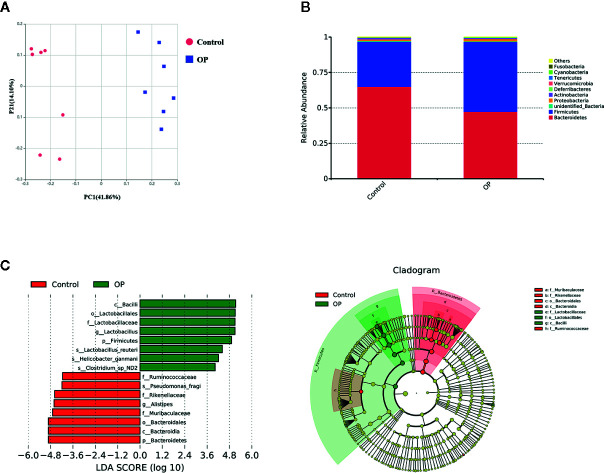

(A) PCoA analysis of the gut microbiota. PC1 = 41.86%, PC2 = 14.10% OP group: red; OP group: blue, Control group: red, n = 7. (B) Difference of gut microbiota between OP group and control group at phylum level, n = 7. (C) LEfSe analysis of gut microbiota for OP group: green, Control group: red, n = 7, LDA score >4.0. Red represents increased flora in OP mice; Green represents increased flora in control mice.